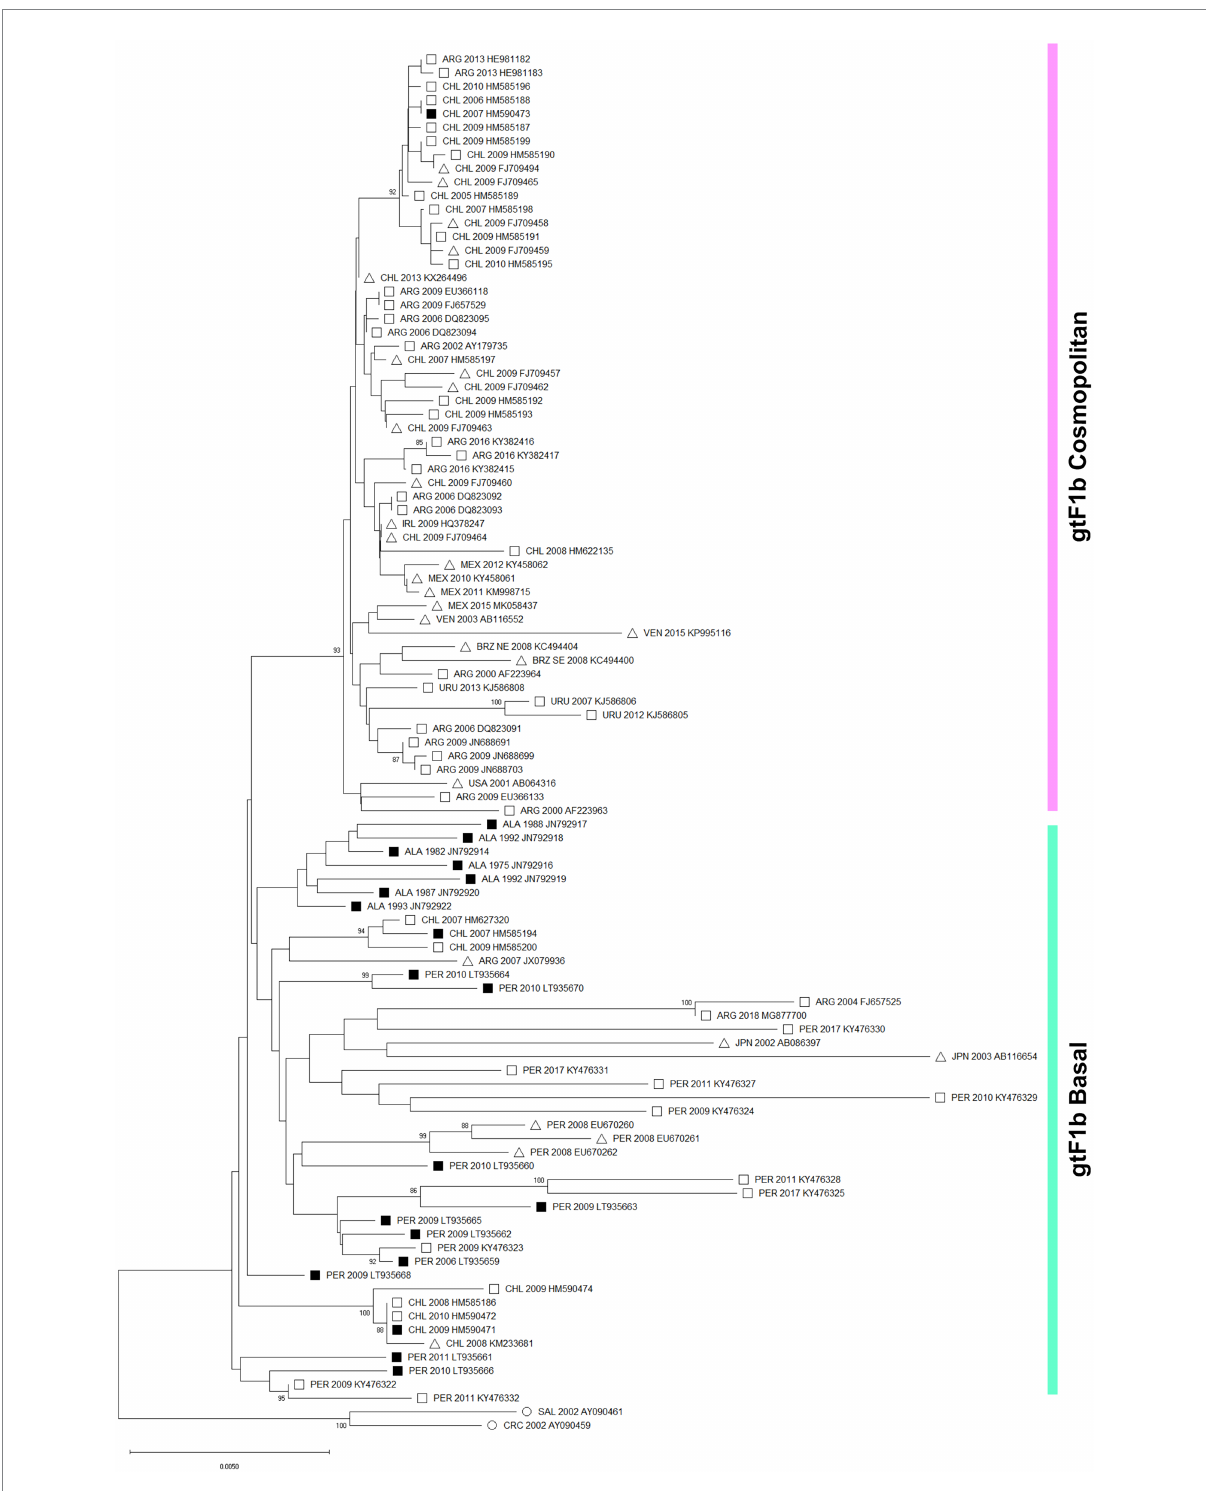
FIGURE 1 Phylogenetic analysis of subgenotype F1b sequences. A maximum likelihood tree was constructed on subgenotype F1b complete genome sequences derived from chronically infected patients ( n = 99), using subgenotype F1a as an outgroup ( n = 2, ○ ). The numbers at each node correspond to bootstrap values (greater than 90%) obtained with 1,000 replicates. The scale bar indicates the genetic distances. Sequences are name by the country of origin, followed by the year of the sample collection and the accession number. ALA, Alaska; ARG, Argentina; BRZ, Brazil; CHL, Chile; CRC, Costa Rica; IRL, Ireland; JPN, Japan; MEX. Mexico; PER, Peru; SAL, El Salvador; URU, Uruguay; USA, United states; VEN, Venezuela. ■ Nucleotide sequences associated with HCC cases. □ Nucleotide sequences non-associated with HCC cases. ∆ Data